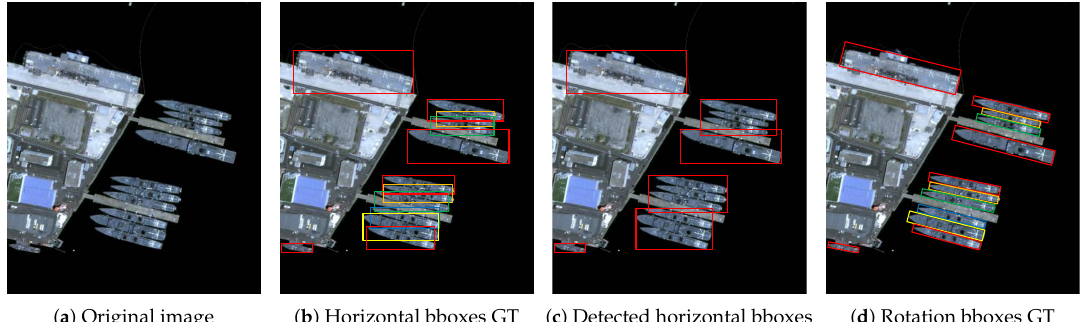
Figure 1. Differences between horizontal bounding boxes (bboxes) and rotation bounding boxes of densely arranged inshore